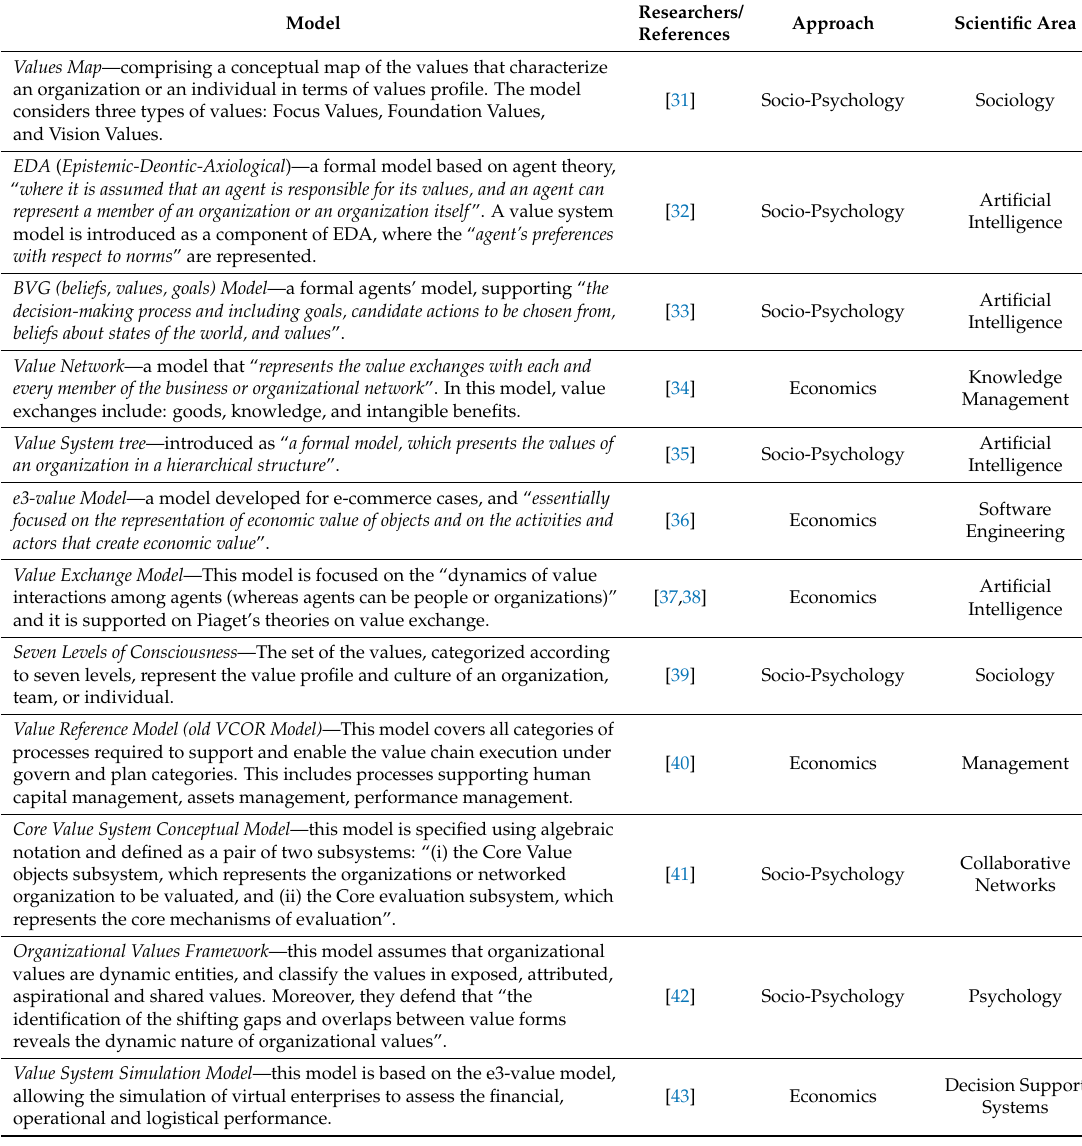
Table 2. A summary of perspectives on value